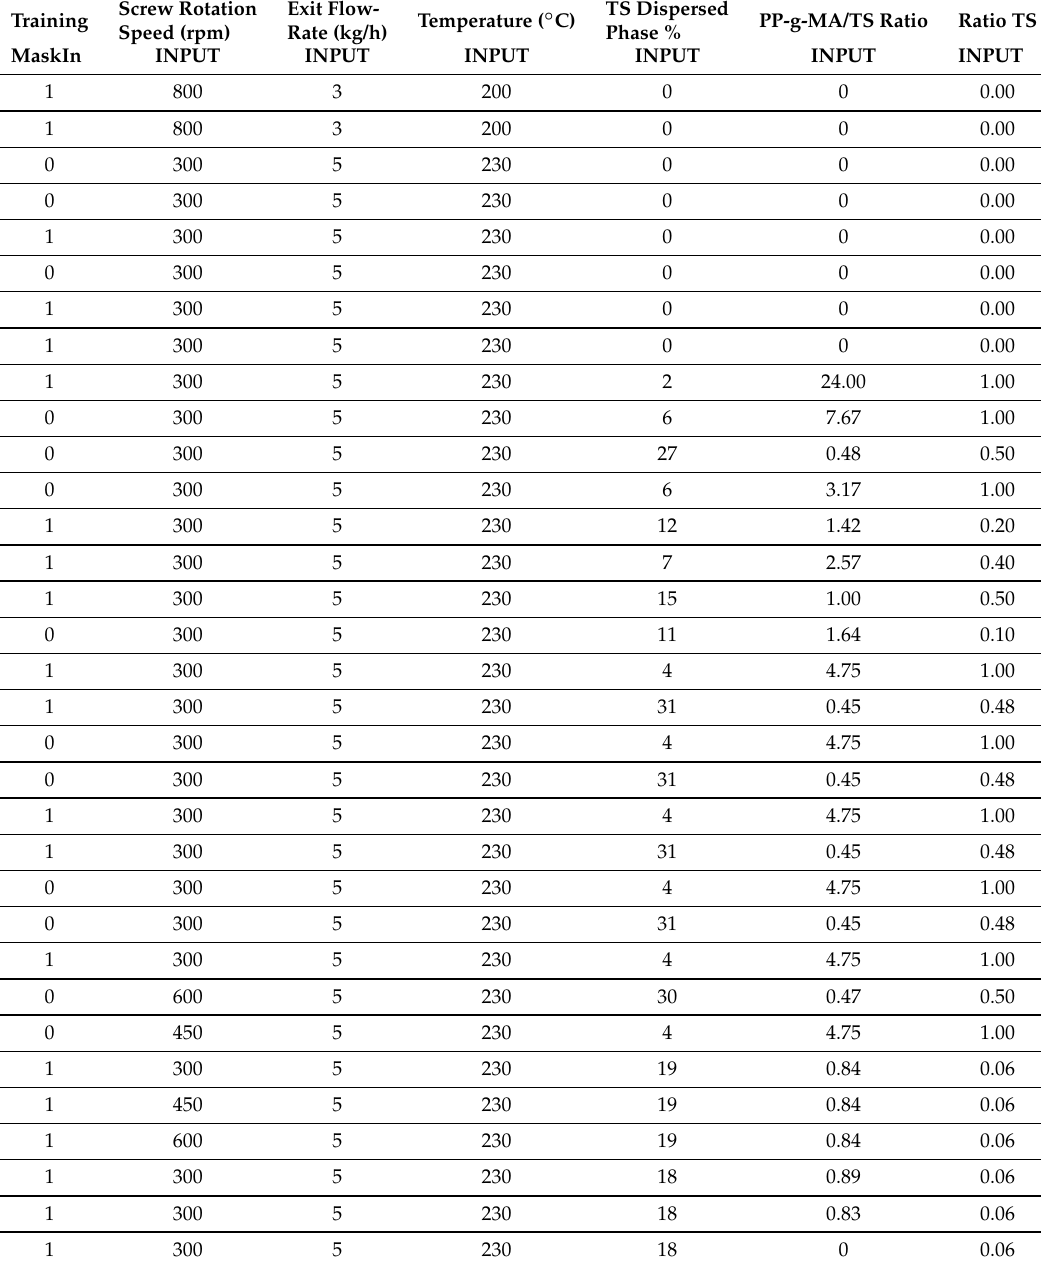
Table A1. Input parameters and training